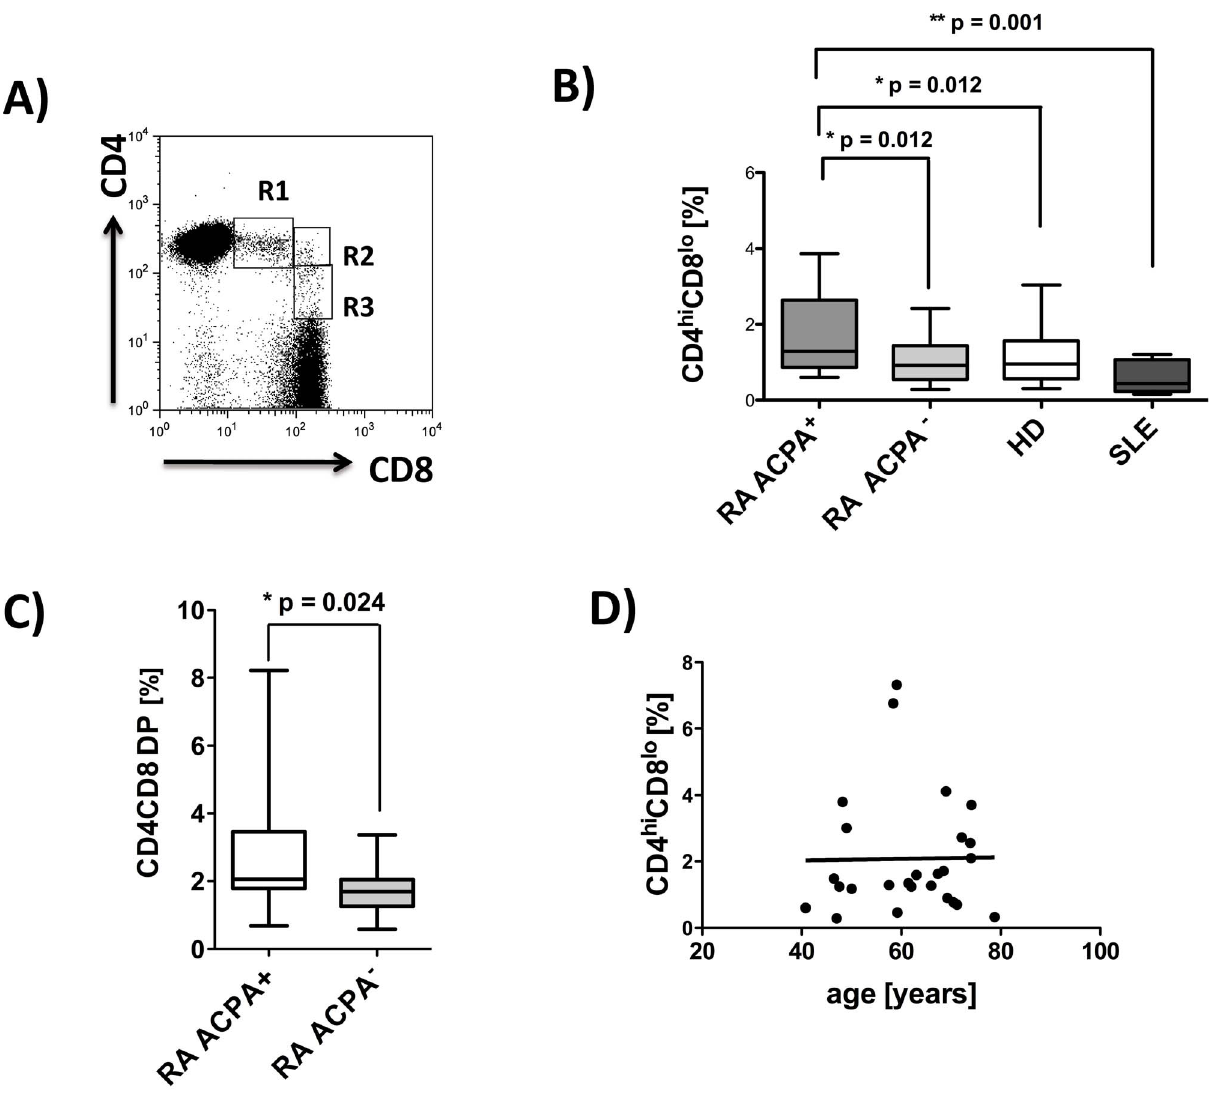
Figure 1. Increased frequencies of peripheral CD4CD8 DP T cells in ACPA + rheumatoid arthritis patients. PBMC were isolated from RA patients (ACPA + , n=37, ACPA 2 , n=20), healthy donors (n=36), and patients with SLE (n=8), and FACS analyses from live cells (PI staining used for exclusion of dead cells) were performed. Analyses for CD4CD8 double positive T cells are always pregated on CD3 positive T cells. A) Representative FACS plot from one RA patient, showing CD4CD8 double positive T cells, R1=CD4 hi CD8 lo , R2=CD4 hi CD8 hi and R3=CD4 l u CD8 hi B) Comparison of frequencies of CD4 hi CD8 lo T cells in PBMCs of ACPA + / 2 RA, HD and SLE patients. C) Total CD4CD8 DP T cells in ACPA + (n=19) and ACPA 2 (n=20) RA patients. D) Correlation analysis for frequencies of CD4 hi CD8 lo T cells with age in ACPA + RA patients. Box plots depict median, interquartile range and 10–90 percentile. Significance as given, *p , 0.05, **p , 0.01.